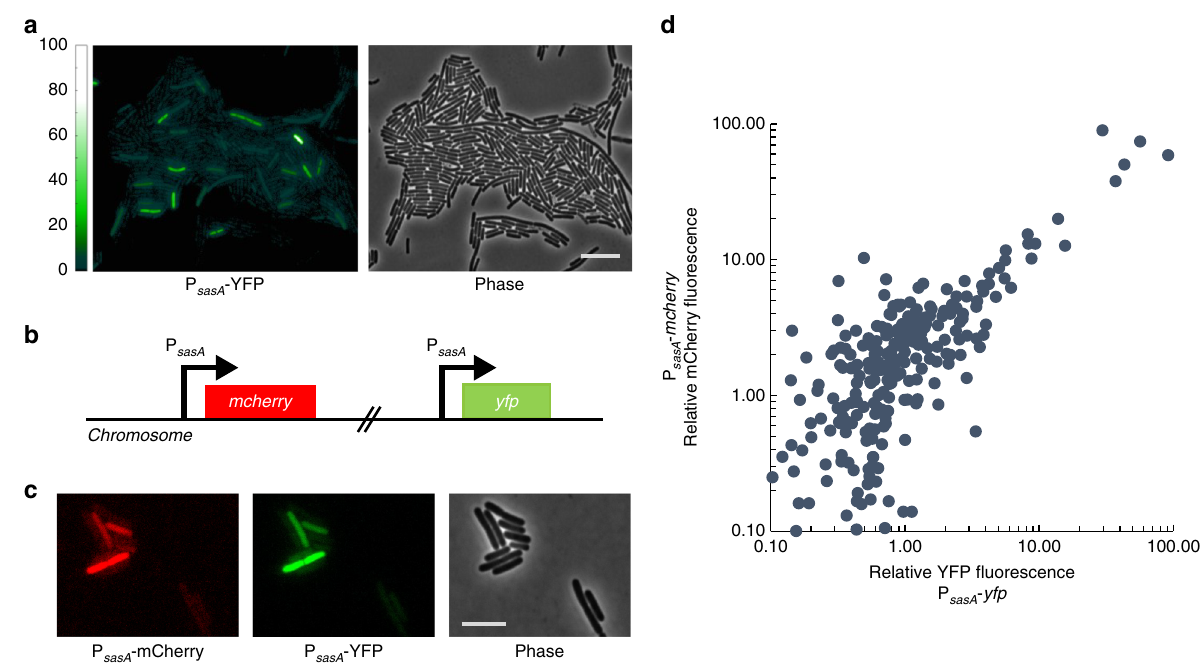
Fig. 1 sasA exhibits cell-to-cell variability in expression. a P sasA - yfp expression in log phase culture. Left : YFP image. Color scale indicates the fold change relative to the population average. Right : Phase contrast. Scale bar indicates 10 µ m. b Schematic of the dual-color transcriptional reporter strain used to characterize the noise in sasA expression. Two copies of the sasA promoter driving different reporters (P sasA - yfp , P sasA - mcherry ) are inserted at separate ectopic loci. c Evidence for extrinsic noise in sasA expression. Images of single cells from the dual reporter strain with signi fi cant fl uorescence shown in mCherry (Left), YFP (Center), and phase contrast (Right) channels. Scale bar indicates 5 µ m. d Quanti fi cation of cellular fl uorescence intensities for single cells in the experiment described in b , c . Values were normalized relative to the population mean value for each channel. Data shown was measured on ~580 cells with detectable fl uorescence in both channels. The fl uorescence of the two reporters have a Pearson ’ s correlation coef fi cient of r ~ 0.90 ± 0.08 (mean ± SEM, 4 experiments). For each reporter, the CV ~ 4.95 ± 0.42 (mean ± SEM, 4